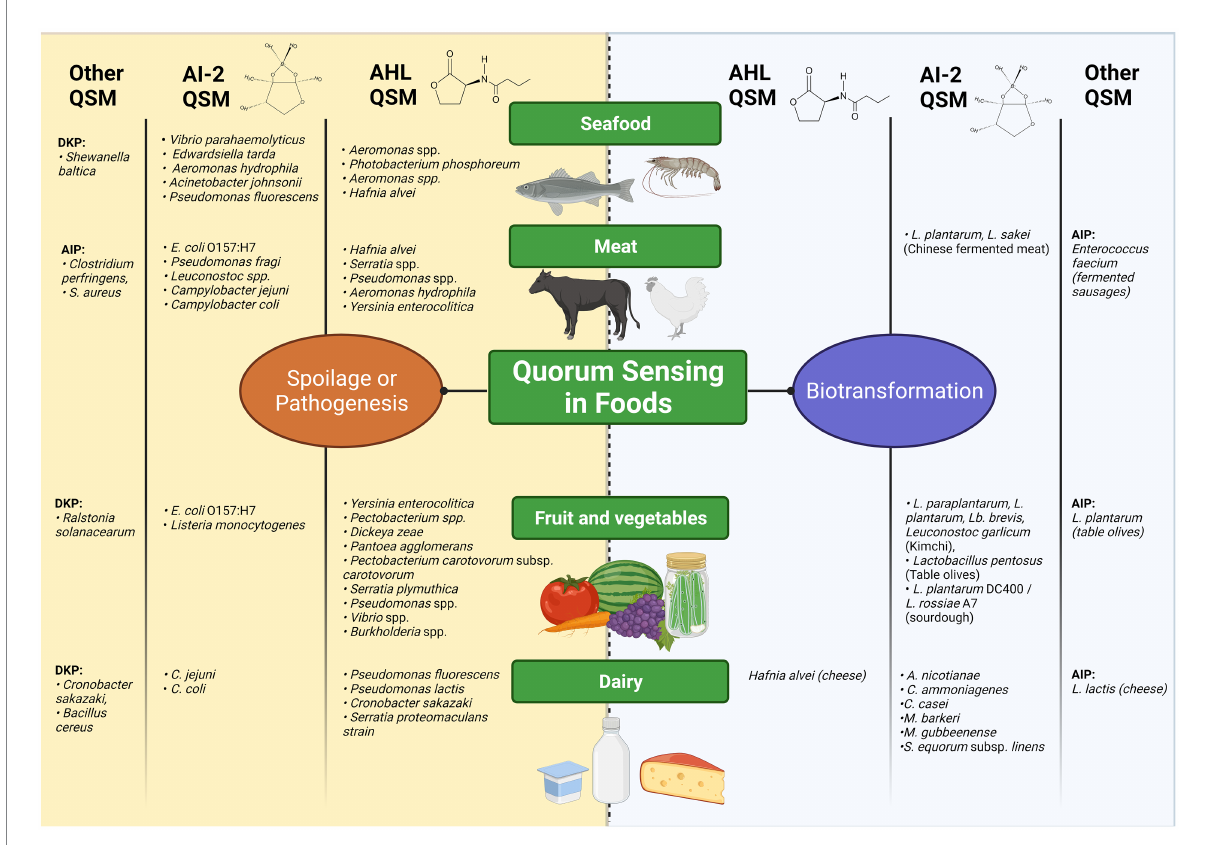
FIGURE 2 Overview of Quorum Sensing Processes as involved in food production, adapted from (Blana, Doulgeraki and Nychas, 2011; Plummer, 2012; Nahar et al., 2018; Quintieri et al., 2020; Wang and Xie, 2020). The left hand side of the figure in yellow maps food-associated bacteria reported in the literature to utilise QS for spoilage or pathogenesis, organised into columns based on the class of QSM (AHL, AI-2 and others) and by the type of food in which they are reported. This scheme is repeated on the right hand side in blue for those food-borne bacteria with positive attributes in food with respect to biopreservation and biotransformation. Created with